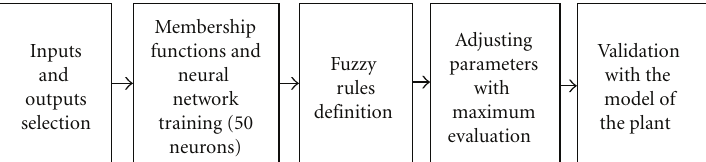
Figure 4: Design of the position controller.